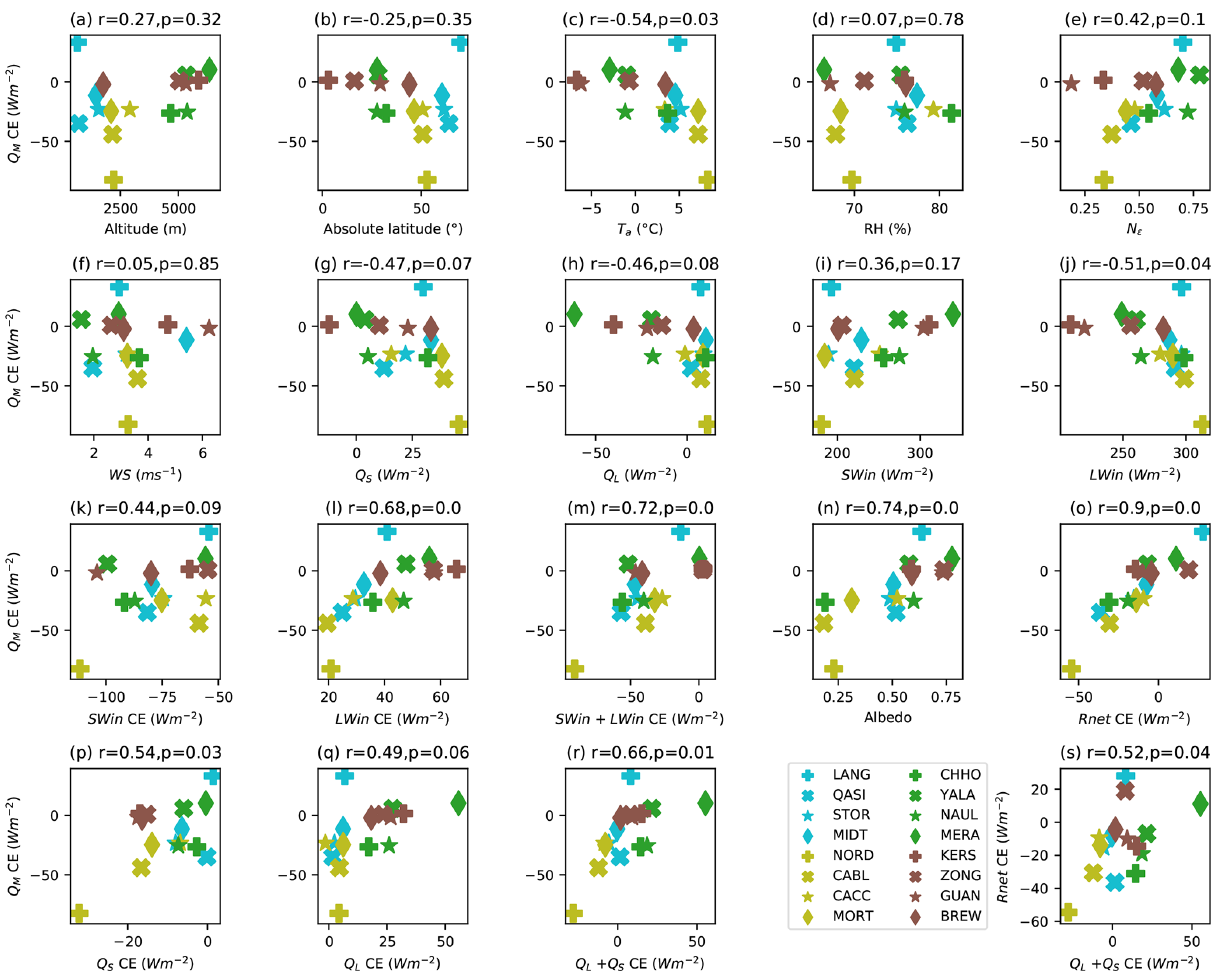
Figure 12. The variation in average melt-season Q M cloud effect (CE) with (a) station altitude; (b) absolute station latitude; and average melt-season (c) T a , (d) RH, (e) N ε , (f) wind speed (WS), (g) Q S , (h) Q L , (i) SWin, (j) LWin, (k) SWin CE, (l) LWin CE, (m) SWin + LWin CE, (n) albedo, (o) Rnet CE, (p) Q S CE, (q) Q L CE and (r) Q s + Q L CE. (s) Variation in Rnet CE with Q s + Q L CE. See Sect. 2.5 for definition of CE. Average melt-season values are calculated by averaging values from the five cloudiness bins